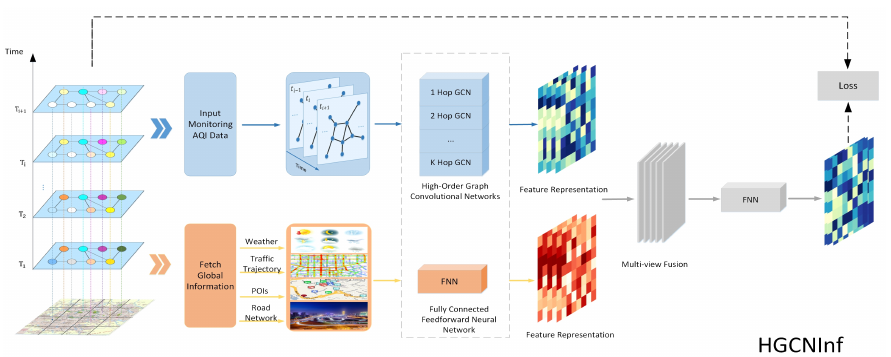
Figure 6. The framework of the air-quality-inference model. The specific structure of the higher-order grapth convolutional network is shown in Figure